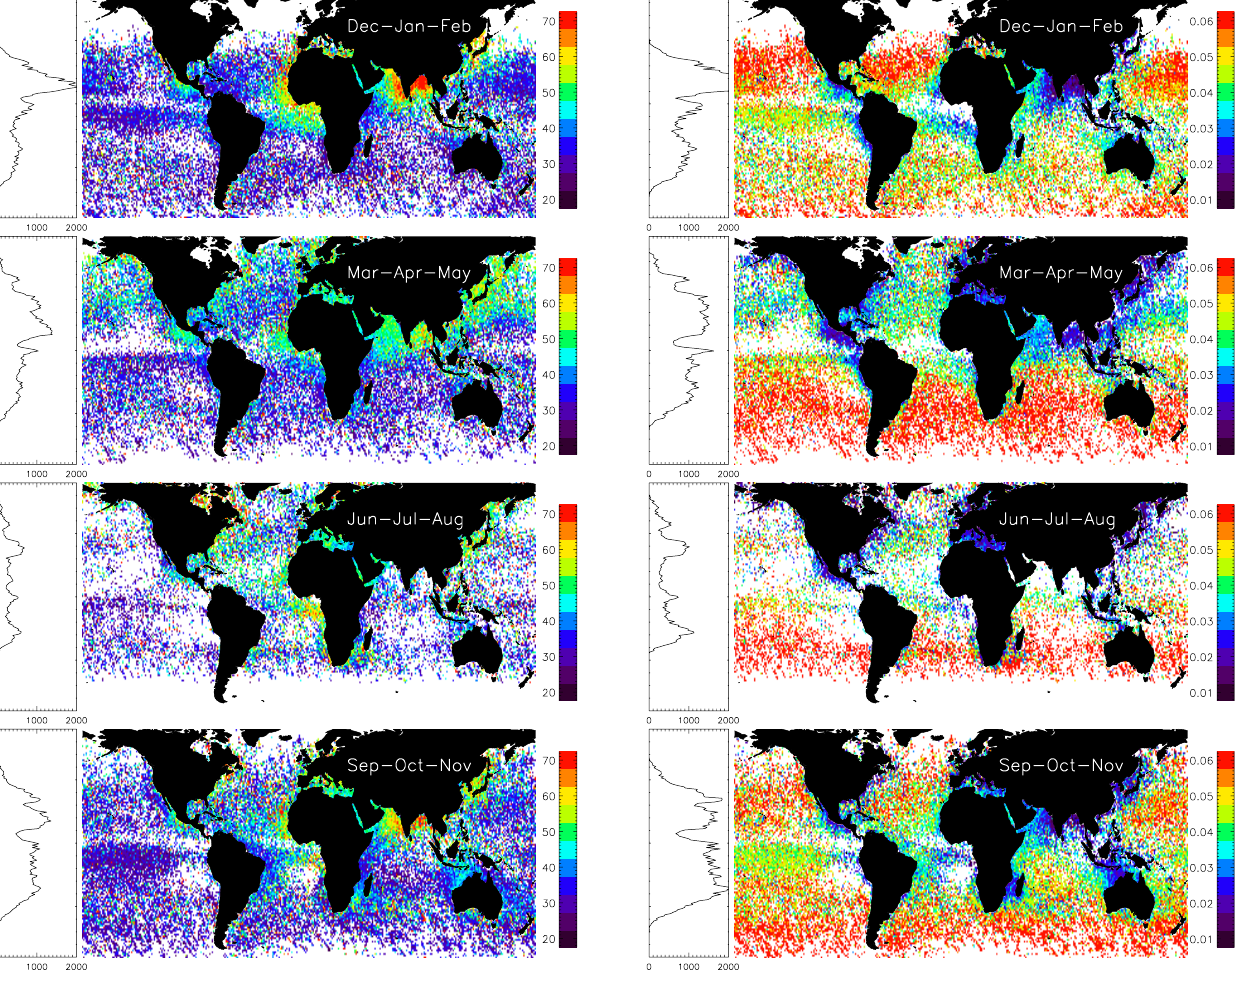
Fig. 4. Seasonal maps of the extinction-to-backscatter ratio (EBR) as derived from the PARASOL measurements acquired in the backscatter viewing geometry. The plot on the left shows the num- ber of estimates per 1 ◦ latitude band.